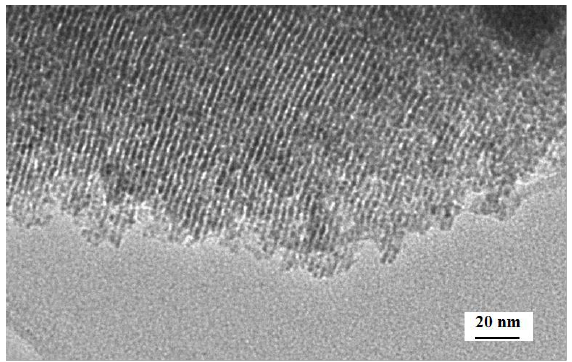
Figure 7. TEM image of the m-SnO 2 powders.